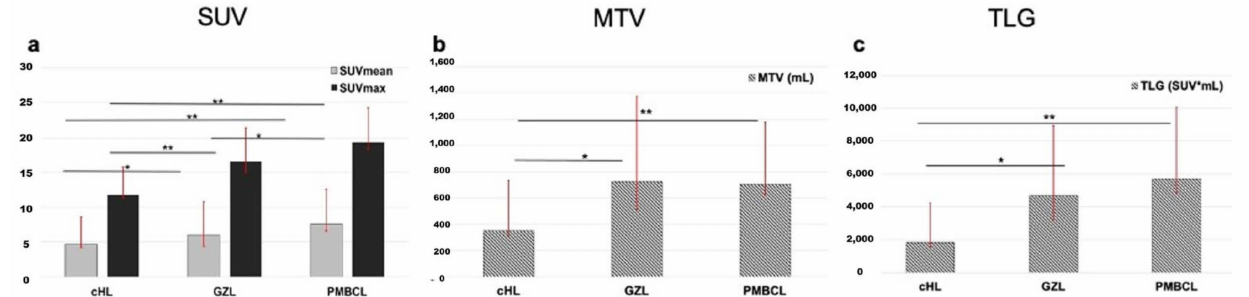
Figure 3. Histograms representing mean SUVmax and SUVmean ( a ), MTV ( b ) and TLG ( c ) in the subsets of cHL, GZL and PMBCL. * p < 0.05, ** p < 0.01. Among first-order variables, histogram skewness and kurtosis were significantly different between groups ( p < 0.001). PMBCL showed significantly lower values with respect to the other groups, indicating asymmetrical histograms with left-sided skewness. On the contrary, cHL showed significantly higher positive values than the other groups, indicating asymmetrical histograms with right-sided